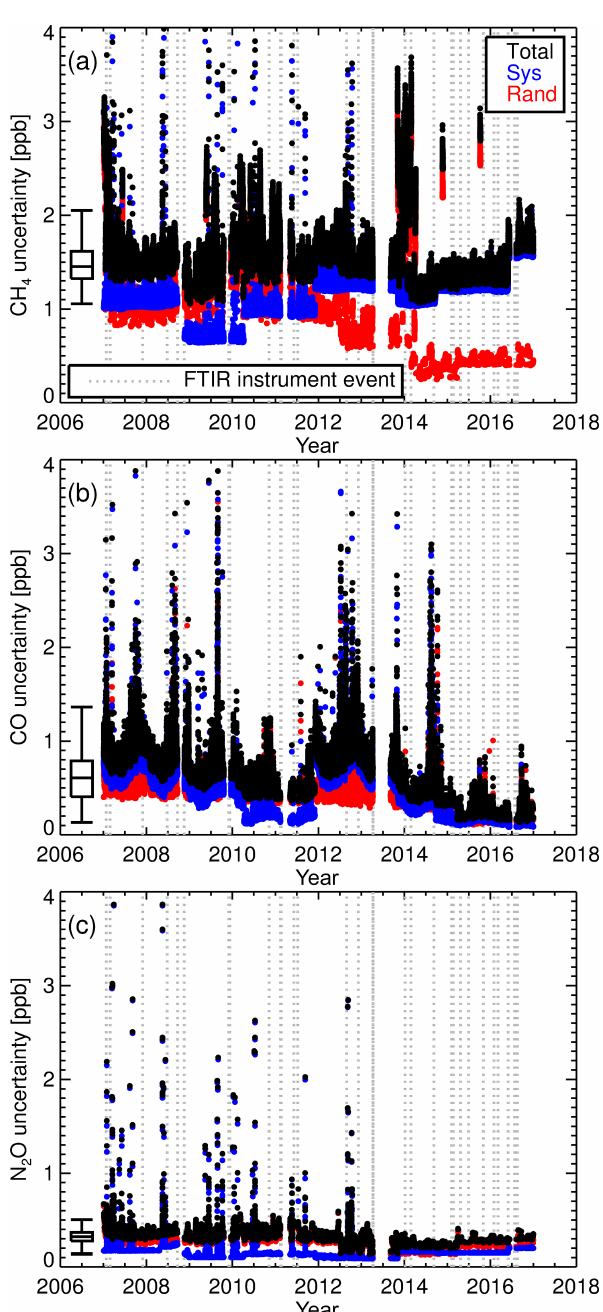
Figure 13. (a) CH 4 measurement uncertainties: total, systematic (Sys) and random (Rand). A box plot statistical summary for total uncertainty is overlaid. Panels (b) and (c) show the same as (a) but for CO and N 2